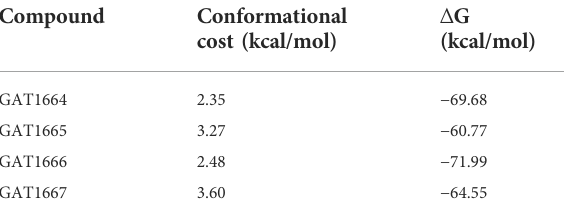
TABLE 1 The conformational cost of GAT compounds is displayed as well as the relative af fi nity represented by binding energy.